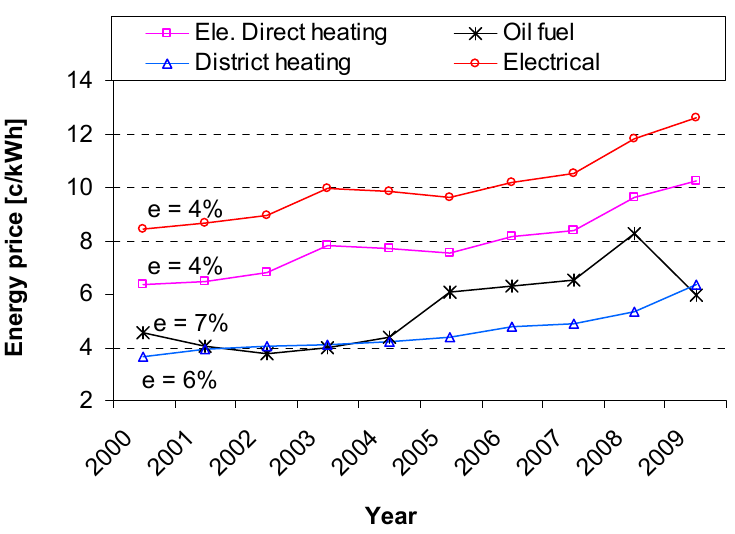
Figure 4. Year-on-year changes in the Consumer Price Index (inflation rate), normal interest rate, and real interest rate (%). These trends are taken from [60,61].